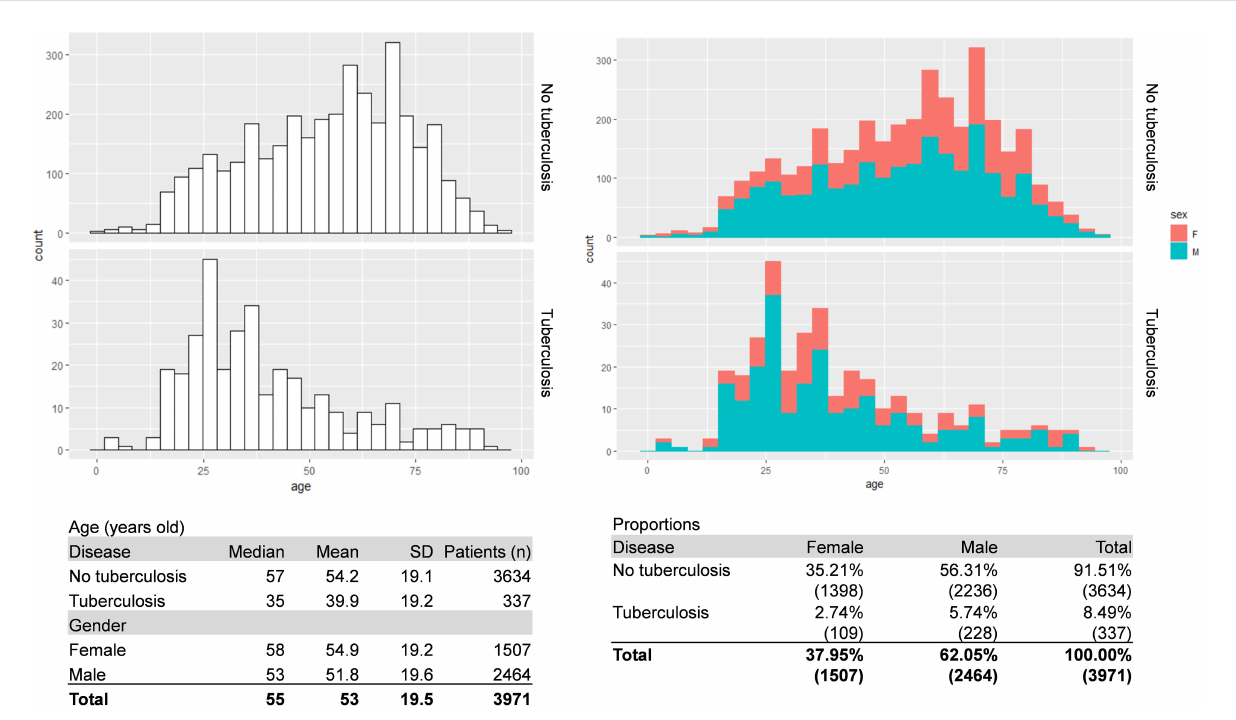
FIGURE 1 Patient ’ s demographic. The fi gure shows the patient ’ s distribution of ages at fi rst consultation by gender and disease status. A composite gold standard based on microbiological results and clinical data was used for disease